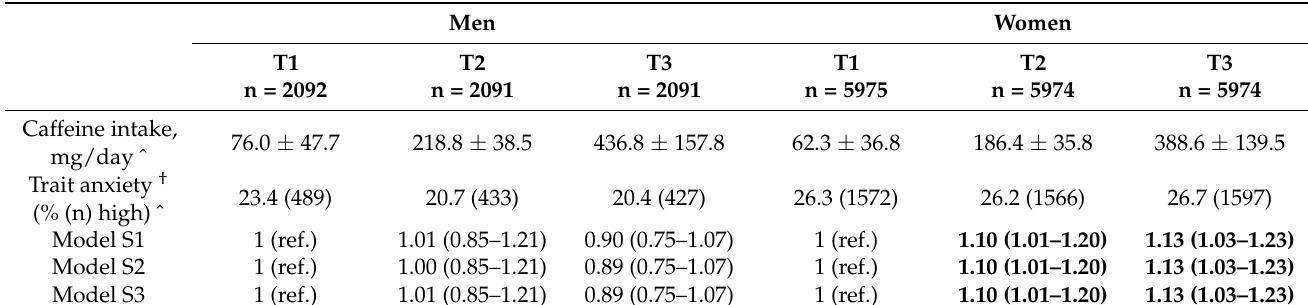
Table 5. Sensitivity analyses of the association (odds ratio, 95% CI) between tertiles of caffeine intake and odds of high trait anxiety in women and men from the NutriNet-Sant é cohort (n = 12,923) according to sugar intake.